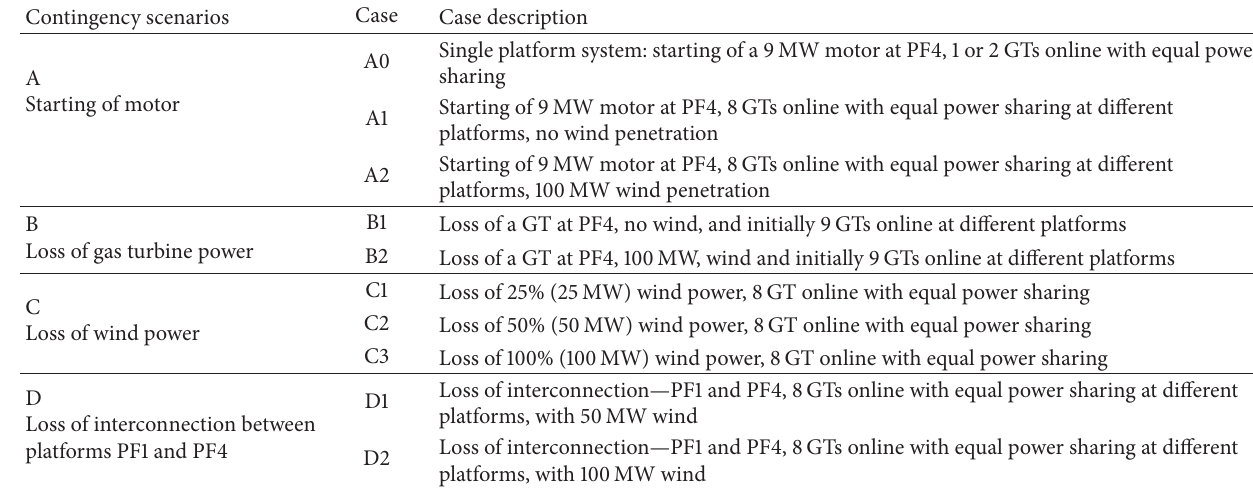
Table 6: Selected critical simulation cases.